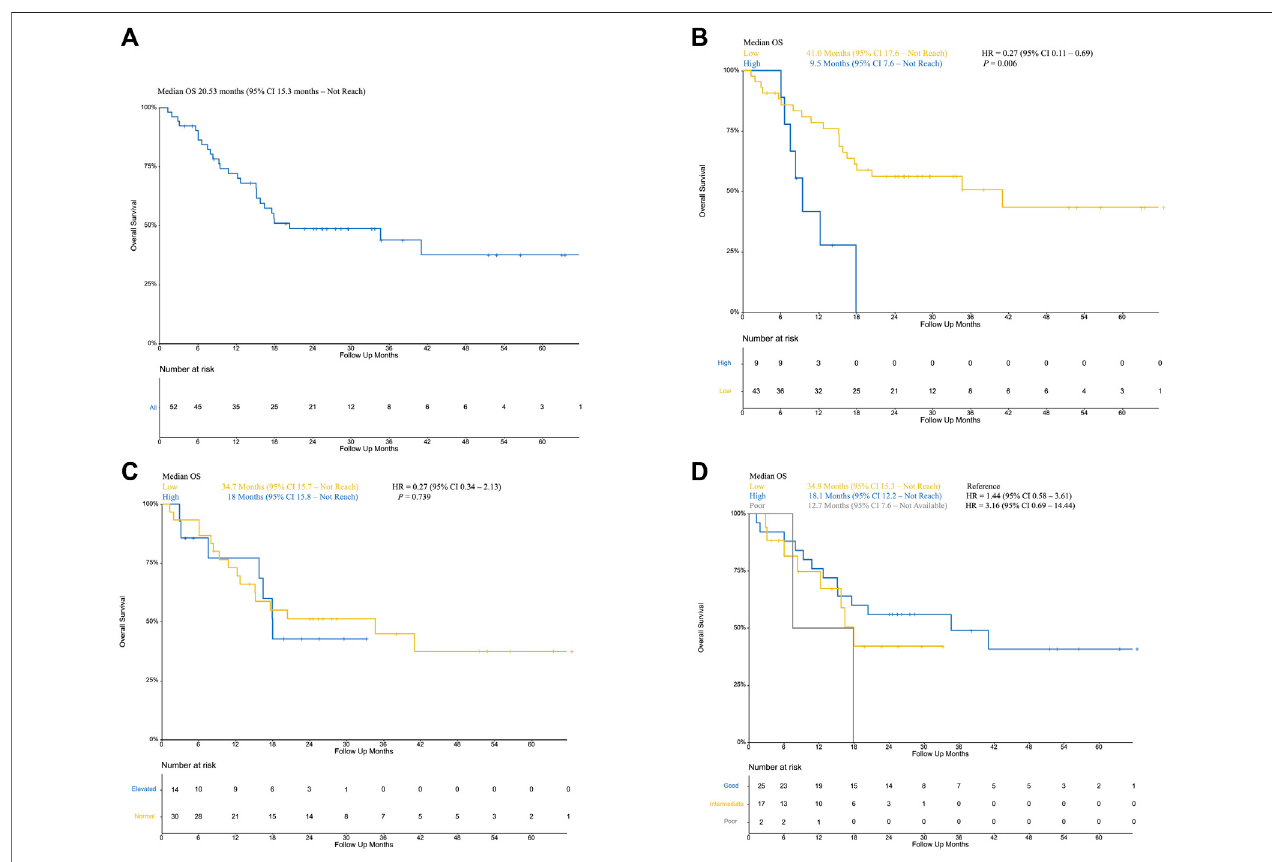
FIGURE 2 | (A) : Overall survival of included patients; (B) Kaplan – Meier curve of low NLR patients (yellow) and high NLR (blue, as reference) patients; (C) Kaplan – Meier curve of normal LDH (yellow) and elevated LDH (blue, as reference); (D) Kaplan – Meier curve of poor mUIPI (gray), intermediate mUIPI (yellow), and good mUIPI (blue, as